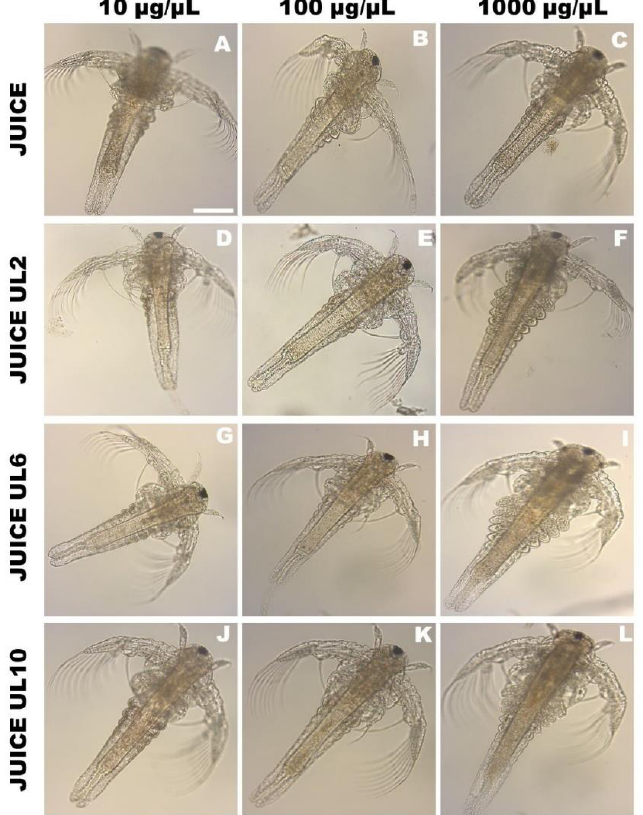
Figure 1. Morphological changes in the Artemia salina nauplii after 48 h of exposure under optical microscopy after toxicity test of unprocessed (juice) and ultrasound processed (2/6/10 min) sapota-do-Solimões using Artemia salina nauplii . Unprocessed sapota-do-Solimões 10 µg·mL −1 ( A ), 100 µg·mL −1 ( B ), and 1000 µg·mL −1 ( C ). Ultrasound processed for 2 min sapota-do-Solimões juice